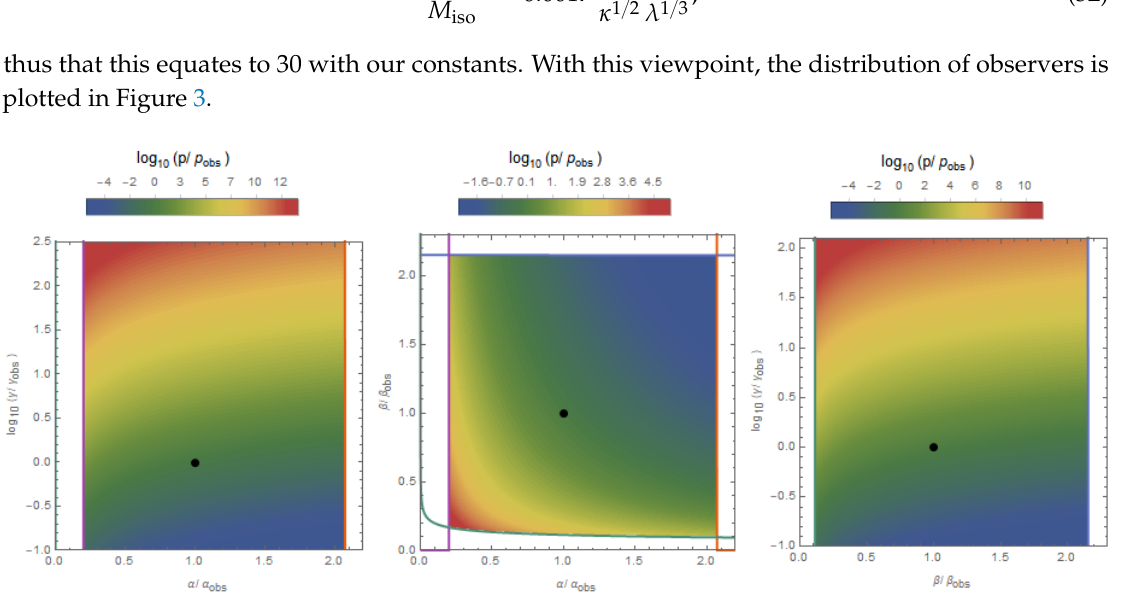
Figure 3. The distribution of terrestrial planetesimals that result from isolated accretion in the α – γ , α – β , and β – γ subplanes, without the subsequent phase of giant impacts. The slope here is q “ 1 { 3. The teal line represents the region where the largest star capable of hosting terrestrial planets is smaller than the smallest possible